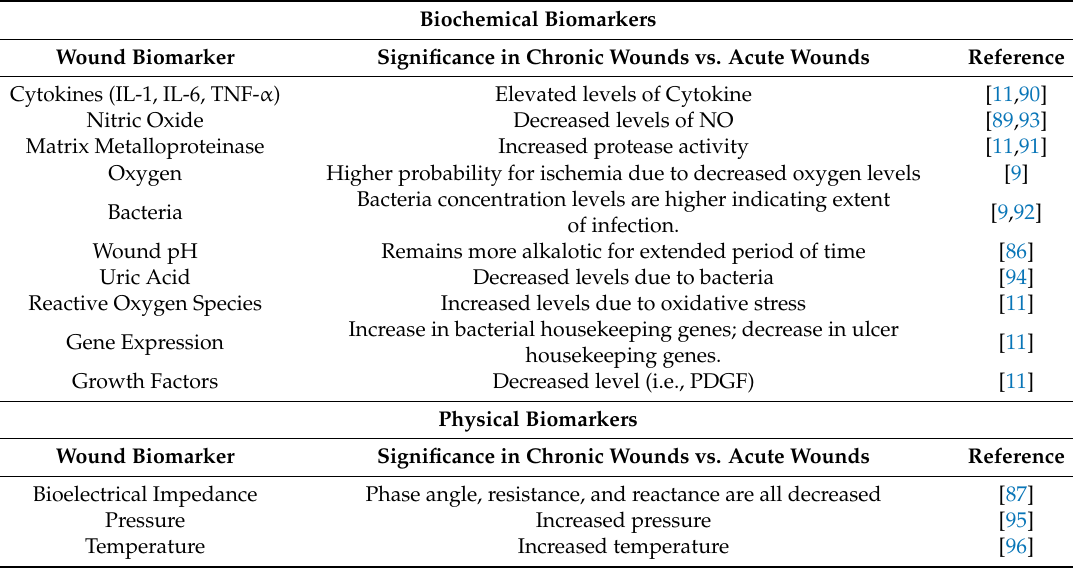
Table 3. Biomarkers associated with chronic wound